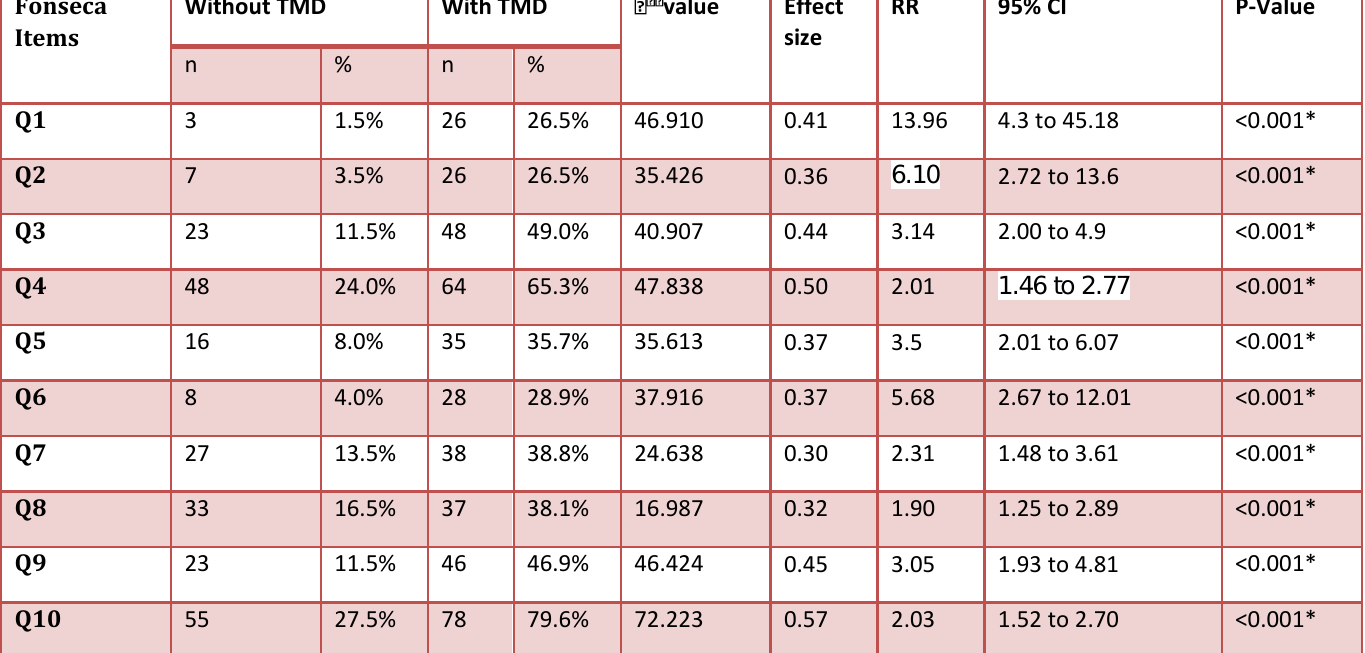
Table 6- Association between Fonseca’s Questionnaire and temporomandibular disorders according to Fonseca Criteria using Chi Square Test.participants using Chi Square TestTestManagement, Commerce & Finance